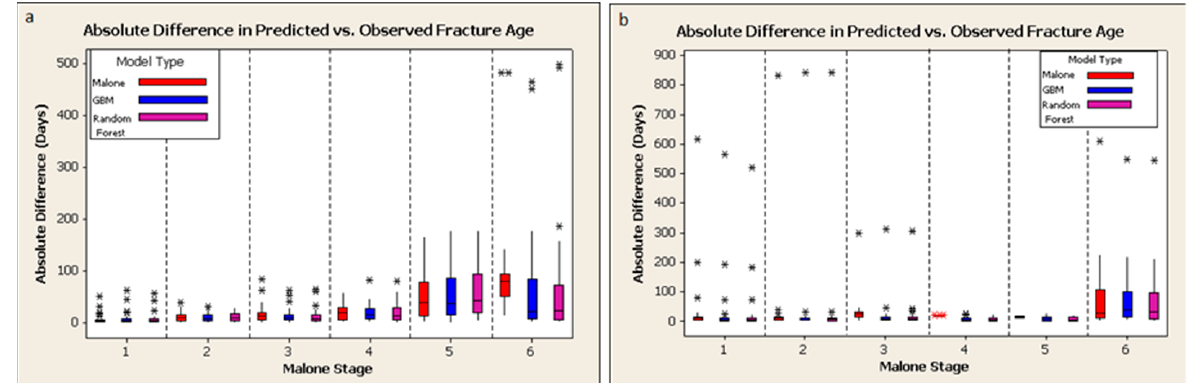
Figure 6. Absolute error in fracture age as predicted by the Malone (red), GBM (blue), and random forest (violet) models, depicted via the six Malone stages: ( a ) displaced, ( b ) buckle fractures.